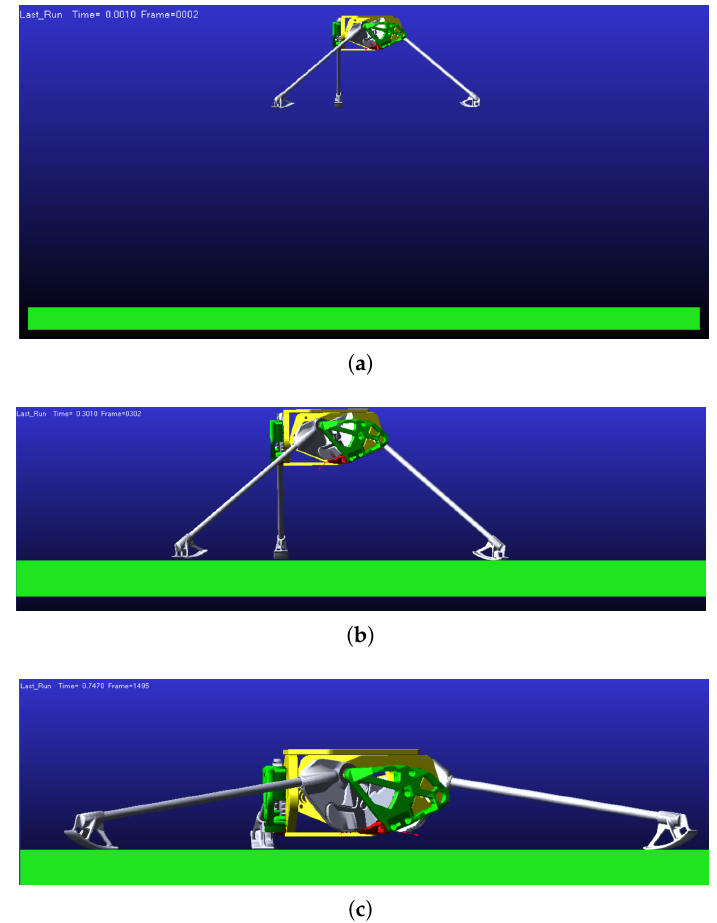
Figure 5. View of the lander MBS and the soil modeled in ADAMS: ( a ) the initial condition of the simulation; ( b , c ) the lander configuration at the beginning and at the end of an impact simulation on a flat surface,